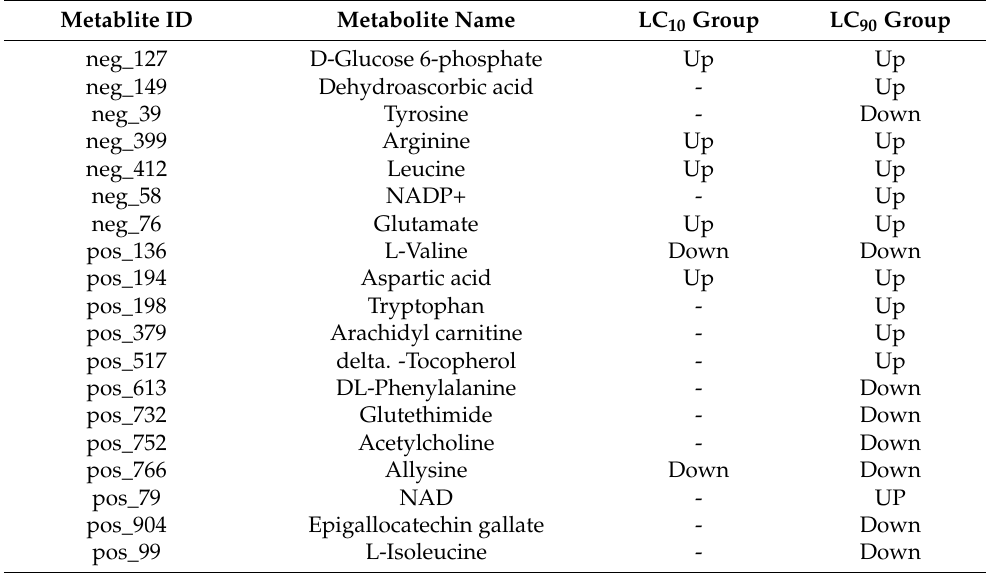
Table 3. Changes of key metabolites in S. frugiperda by exposure to LC 10 and LC 90 dose of the spinetoram compared to the control group ( t -test p <